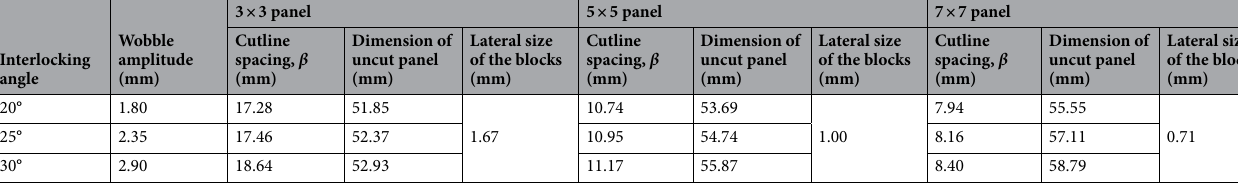
Table 1. Overview of the achievable interlocking angles with the corresponding wobble amplitudes and square panel